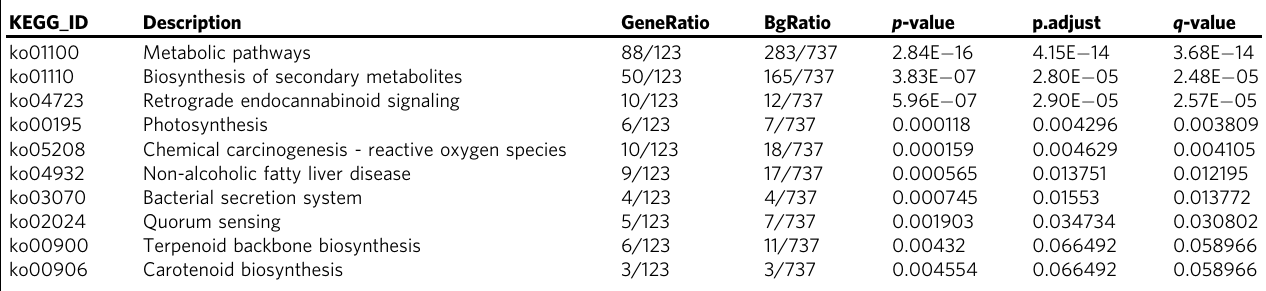
Table 4 Enriched KEGG Orthology categories in the algae-speci fi c gene